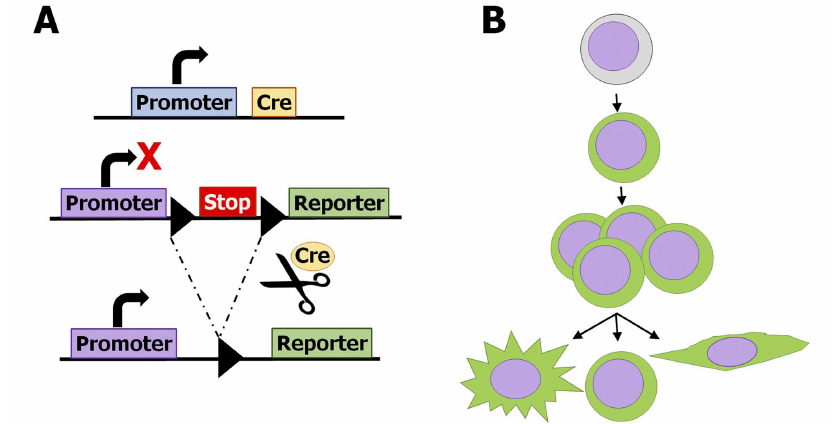
Figure 3. Lineage tracing assay. (A) The Cre/loxP recombinase system. The Cre-recombinase gene of the P1 bacteriophage is placed under the control of a promoter of a gene specifically expressed by the cell population of interest. Cre recombinase efficiently catalyzes recombination of DNA segments between two of its recognition sites, called loxP. The loxP sites flank a stop codon introduced between the promoter and the reporter gene. Activation of the cell population specific gene promoter leads to the expression of Cre recombinase. The Cre-recombinase mediates the deletion of the loxP site–flanked stop codon between the promoter and the reporter gene (GFP, green fluorescent protein in the example). Since the promoter is constitutively active, it induces the permanent expression of the reporter gene. Consequently, the progeny of the positive labeled cell will also express the reporter gene; (B) An undifferentiated stem cell activates its differentiation program. Expression of the specific target gene induces Cre-recombinase expression and subsequently the expression of the product of the reporter gene (GFP). The cell and its progeny are permanently GFP+ (in